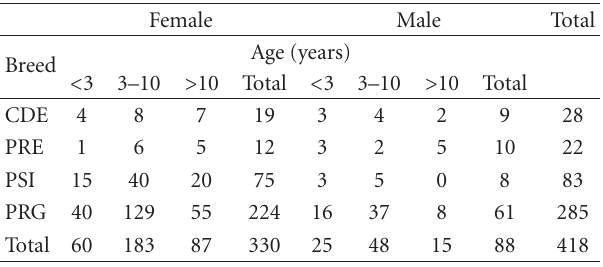
Table 1: Distribution of the fecal samples from horses under an oceanic climate area (NW Spain) according to their breed, sex, and age. Female Male Total